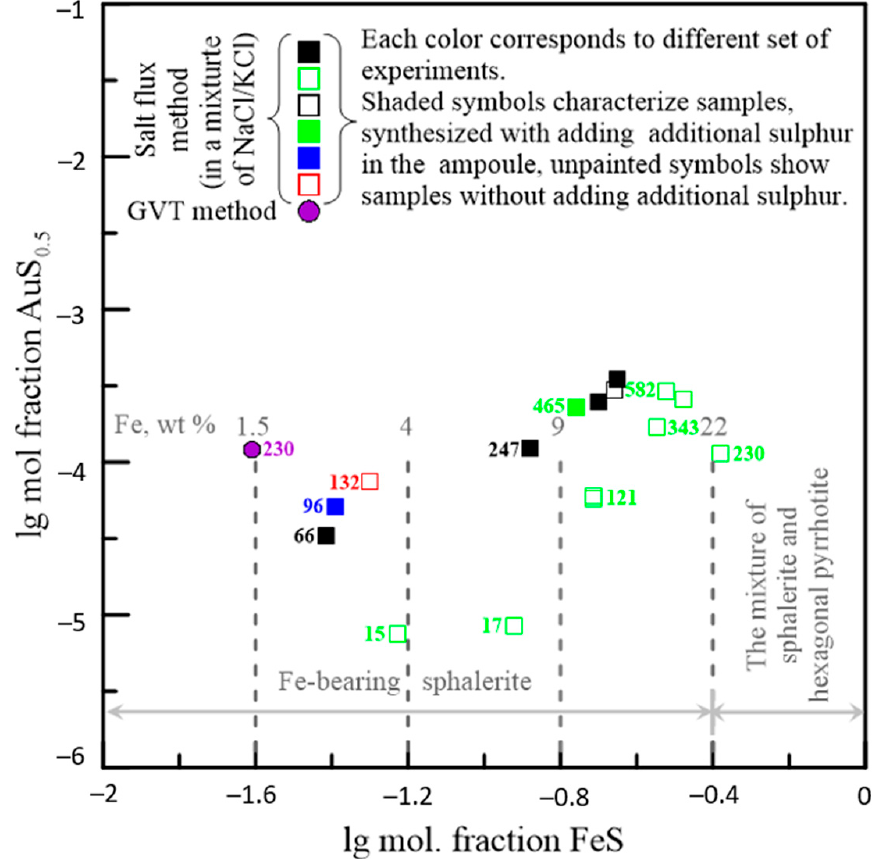
Figure 39. Relation between the Fe and Au concentrations in the synthetic crystals of sphalerite.